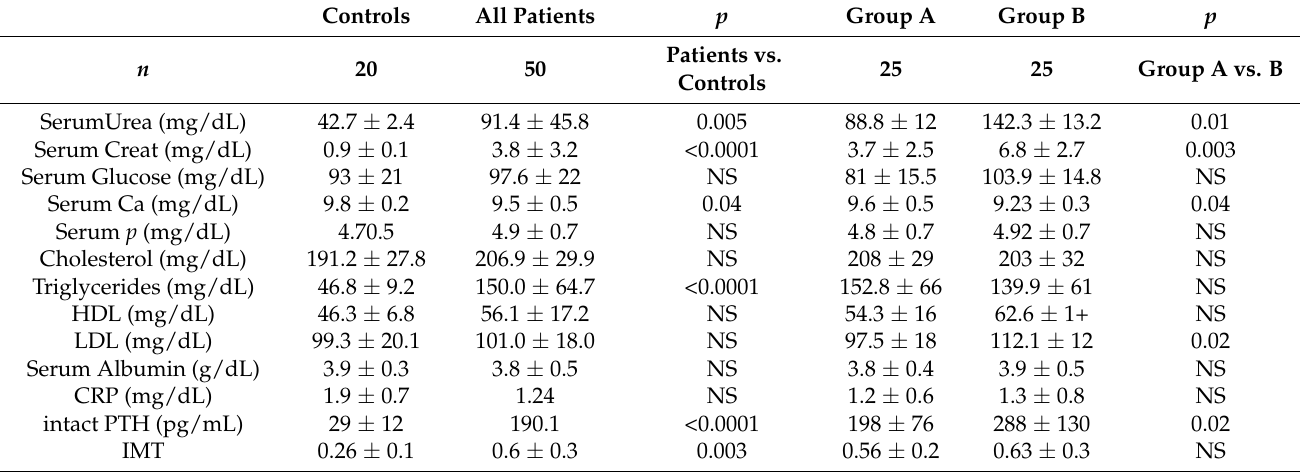
Table 2. Laboratory findings from group A (pre-HD), group B (HD) patients and controls at time of investigation. Controls All